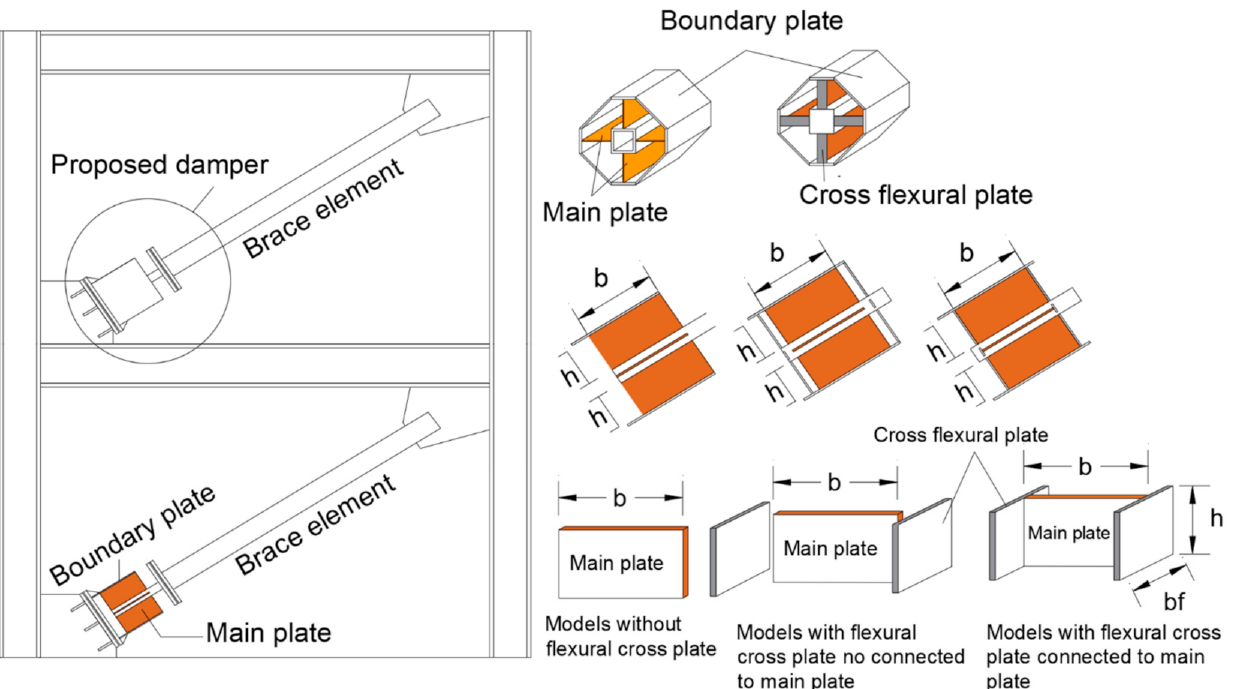
Figure 1. Schematic views and placement of the damper in